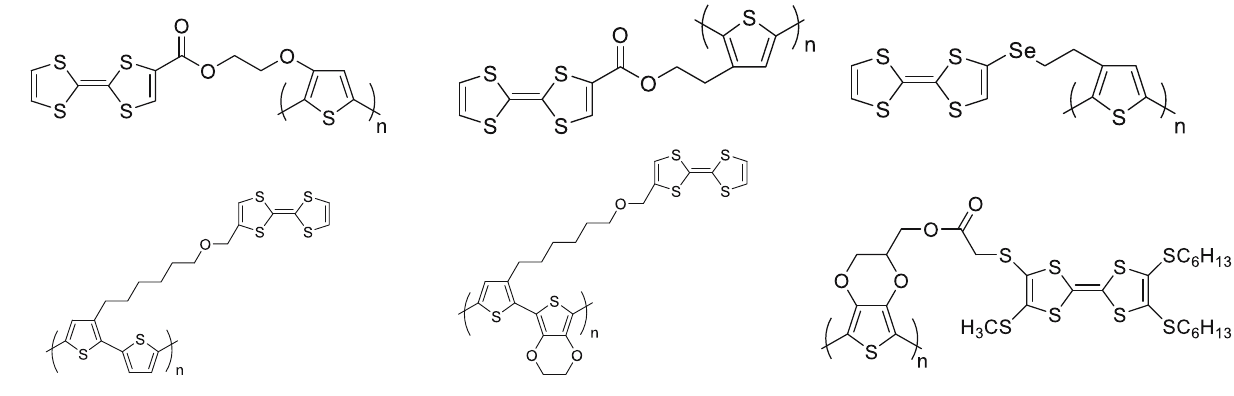
Figure 1: Patterns of some TTF - thiophene polymers ( 15,17,18 )